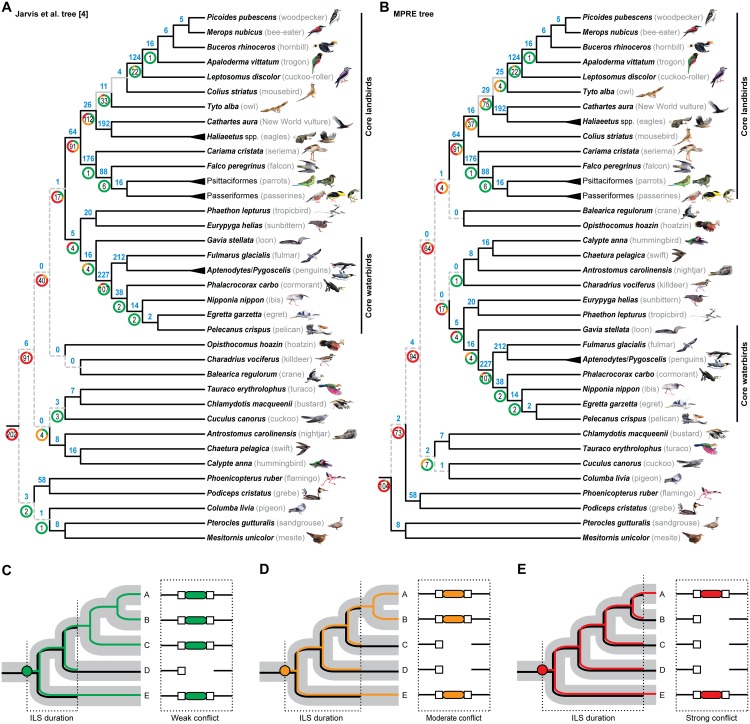
Phylogenetic tree of rare genomic changes reveals varying degree of incomplete lineage sorting across Neoaves diversification.(A) The main whole-genome sequence tree from Jarvis et al. [4] mapped with our 2,118 retrotransposon markers (745 incongruent markers; tree length = 5,579; consistency index = 0.40; retention index = 0.64). (B) The same markers mapped on the single MPRE tree (S2 Data) resulting from analysis of their 2,118 presence/absence patterns (720 incongruent markers; tree length = 5,377; consistency index = 0.41; retention index = 0.66) under Felsenstein’s polymorphism parsimony [16]. Black branches indicate topological concordances between the MPRE tree and the main Jarvis et al. tree [4], and discordances are limited to the deepest neoavian internodes (grey dashed branches) and the conflicting position of the mousebird (grey branches). The amount of ILS-free, conflict-free insertion events (blue bold numbers) was identified for each internode, and numbers within doughnut plots indicate counts of ILS-affected RE insertion events leading to the persistence of insertion polymorphisms across two (green), three (orange), or more (red parts of doughnut plots) speciation events. (C–E) Schematic illustration of the different genealogical fates of segregating presence (colored lines) or absence (black lines) alleles following RE insertion (colored circles) in an exemplary five-taxon species tree. We show one respective example for the different degrees of gene tree–species tree conflict that can be caused by incomplete lineage sorting (ILS) across two (C), three (D), or more than three (E) successive speciation events. Incongruence of RE presence/absence patterns (dashed boxes) is illustrated with REs as colored ovals, target site duplications as white squares, and orthologous genomic flanks as black lines. The bird paintings were generated by Jon Fjeldså (used with permission).